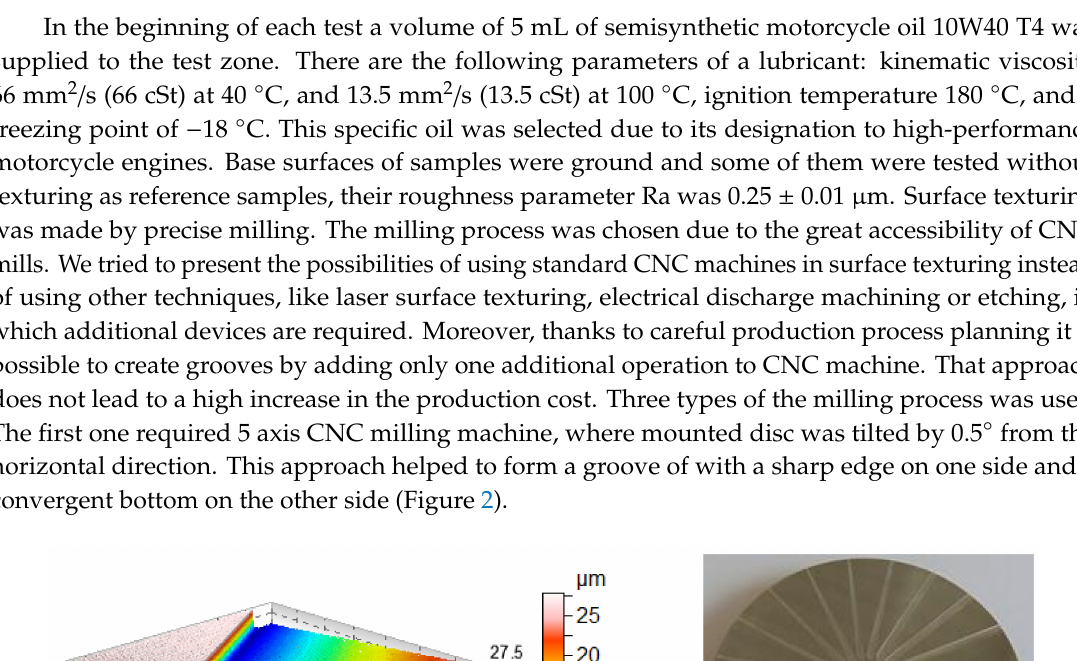
Figure 1. Scheme of counter-sample mounting; 1—sample (rotating disc), 2—self-aligning counter-sample, 3—ball bearing, 4—ball bearing holder, 5—load transmitting rod, FR—friction radius ( a ); view of test chamber ( b ).